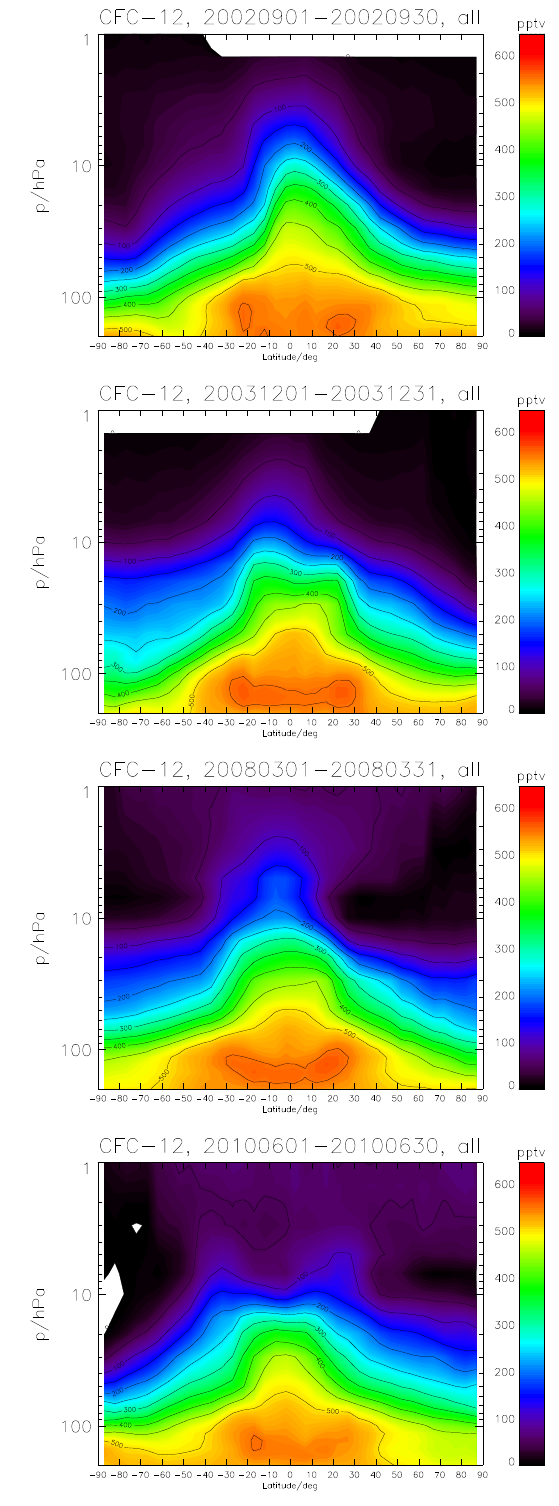
Fig. 8. CFC-12 monthly zonal mean distribution between 200 hPa and 1hPa in September 2002, December 2003, March 2008, and and 1 hPa in September 2002, December 2003, March 2008, and June June 2010.